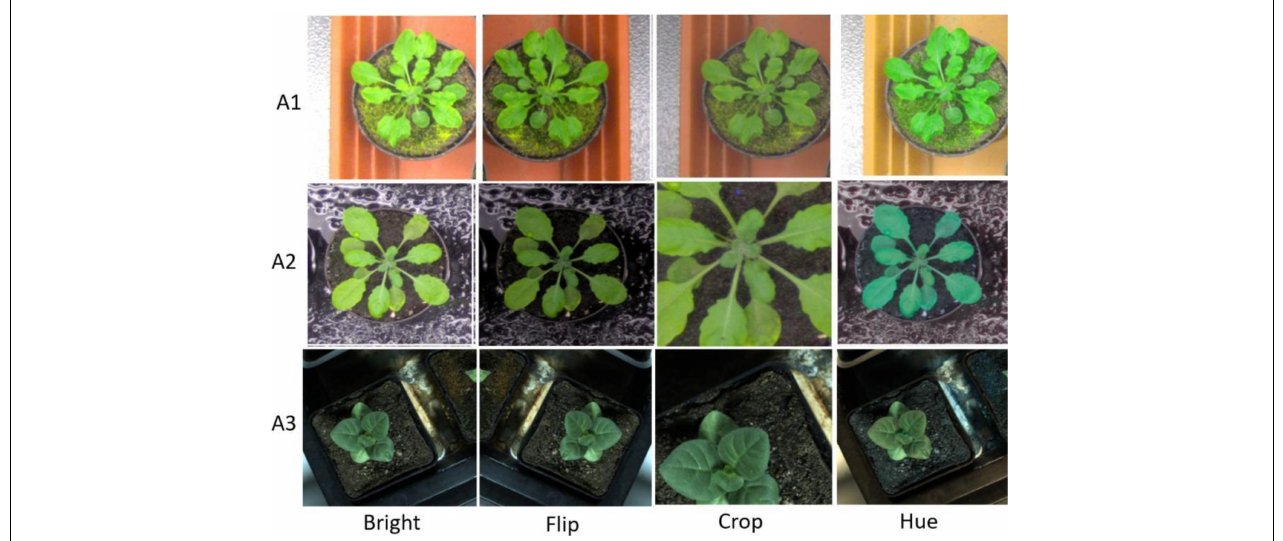
FIGURE 2 | Augmentation samples for training the segmentation network to avoid the risk of over-fitting.